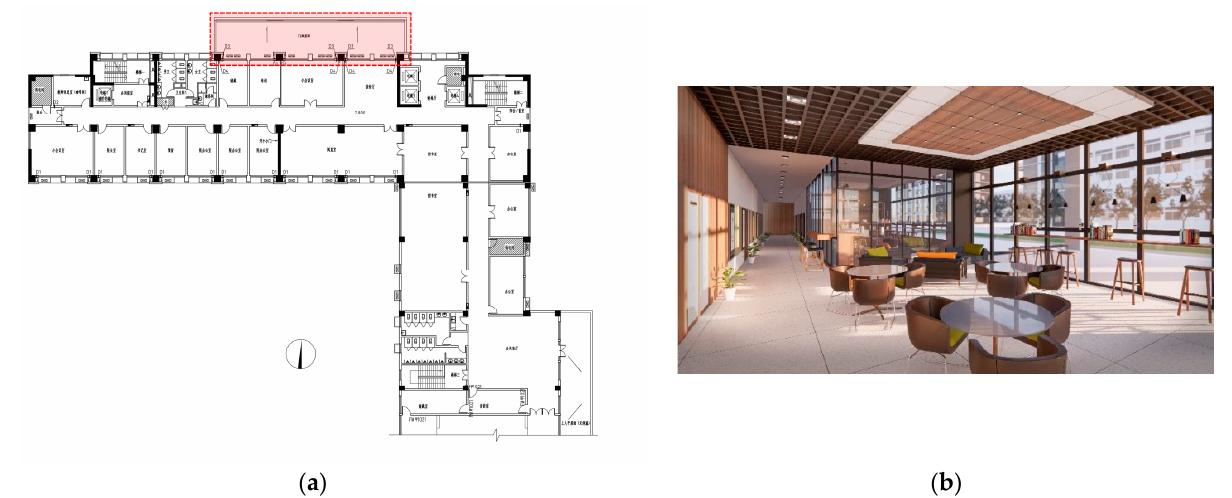
Figure 6. The first-floor cafe after optimal design. ( a ) Optimized plan. ( b ) Rendering of the space after optimal design.